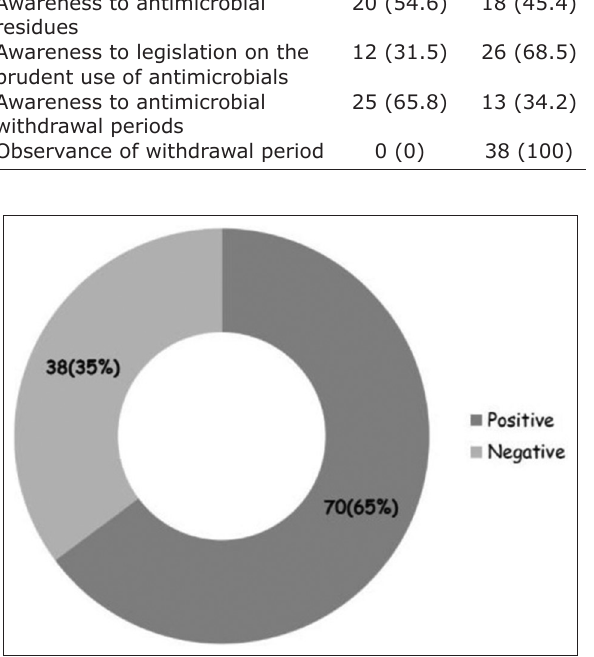
Figure-3: Occurrence of gentamicin residue in commercial birds sold at Ikpa, Nsukka.